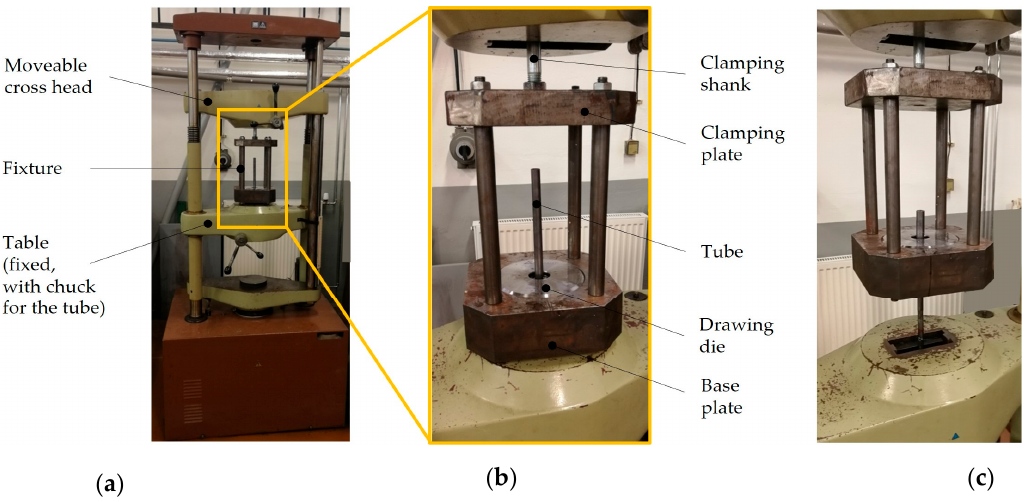
Figure 3. Hydraulic tensile testing machine EU 40 with a clamping fixture for cold tube drawing: ( a ) view of the whole testing machine with the fixture; ( b ) detailed view of the fixture with the tube before the experimental drawing; ( c ) view of the fixture with the tube after the experimental drawing (the tube is clamped in the chuck of the table and does not move while the fixture moves upward along with the drawing die).